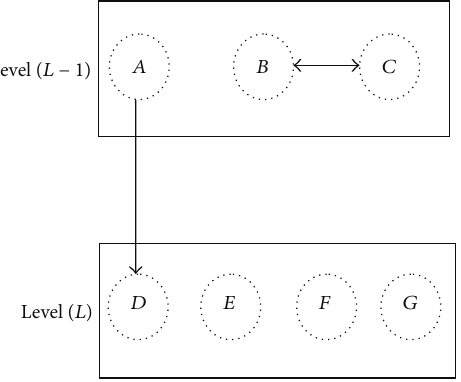
Figure 4: Dynamic cluster